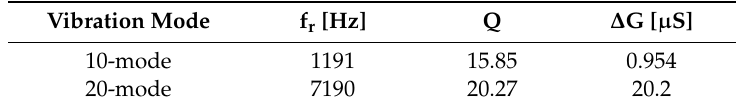
Table 1. Measurement of the resonant frequency, quality factor and conductance of the free-clamped bimorph actuator for di ff erent vibration modes with an impedance analyzer.